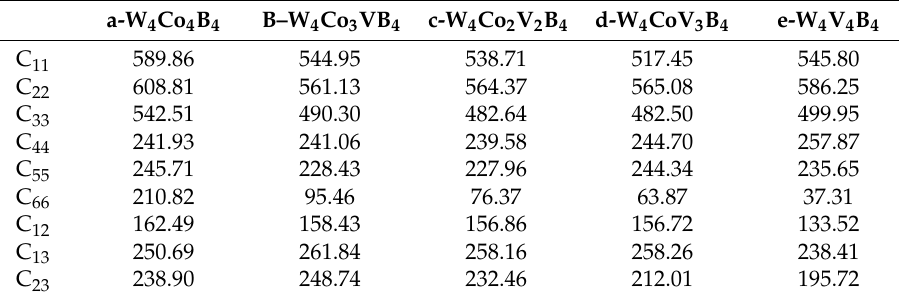
Table 3. The calculated elastic constants (in GPa) of W 8 Co 4 − x V x B